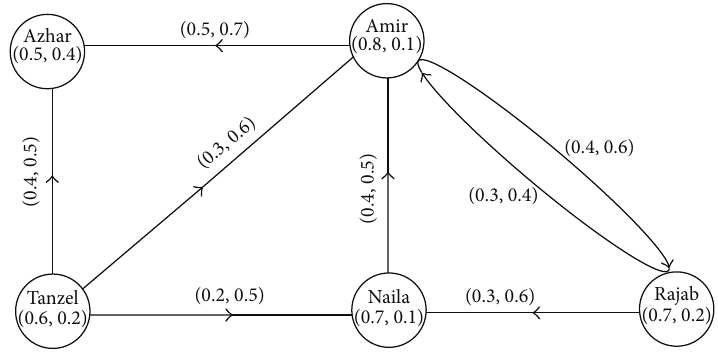
Figure 13: Vague influence